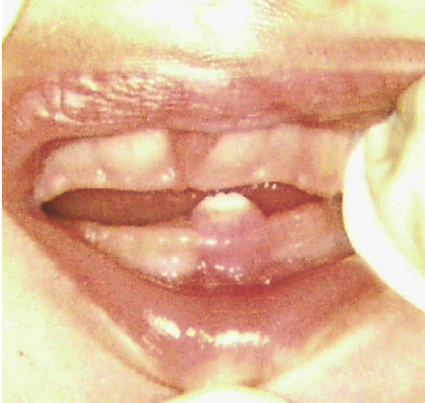
Figure 1: A 5-day-old female infant with partially erupting natal tooth in the anterior mandibular area, exhibiting grade II mobility.